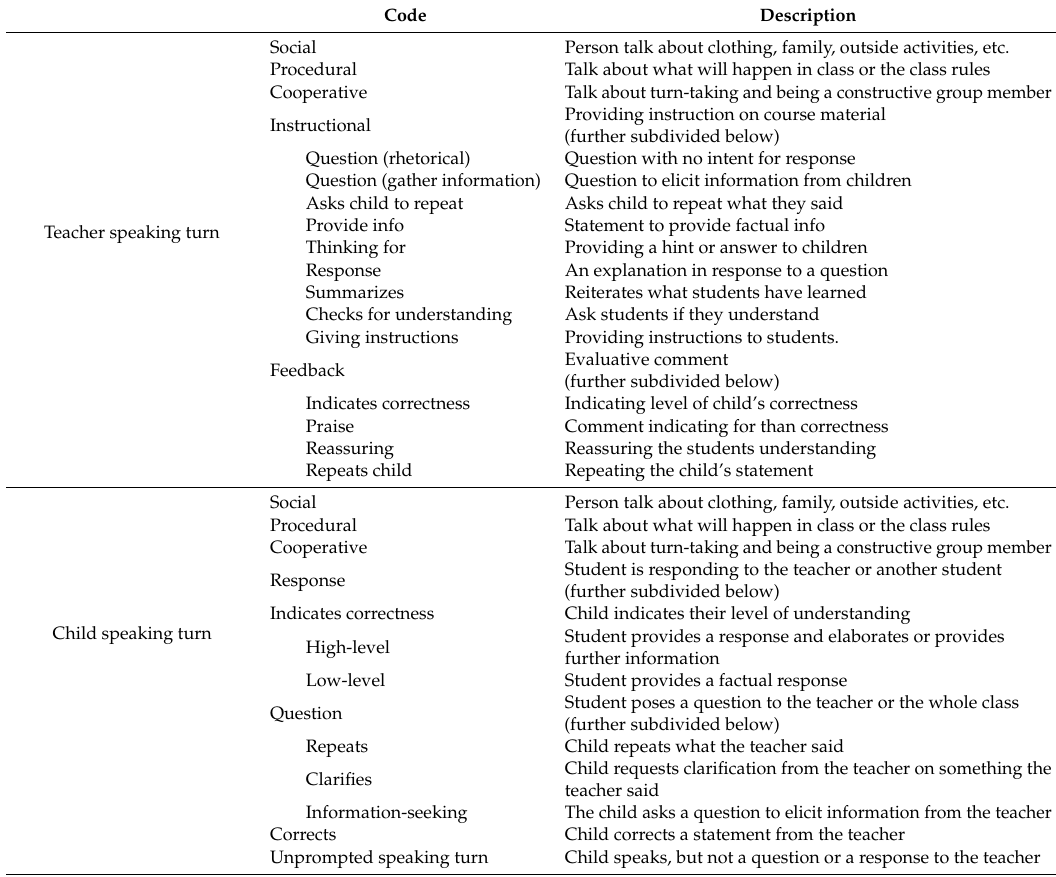
Table 1. Coding scheme used to code videos of student–teacher interactions during robotics